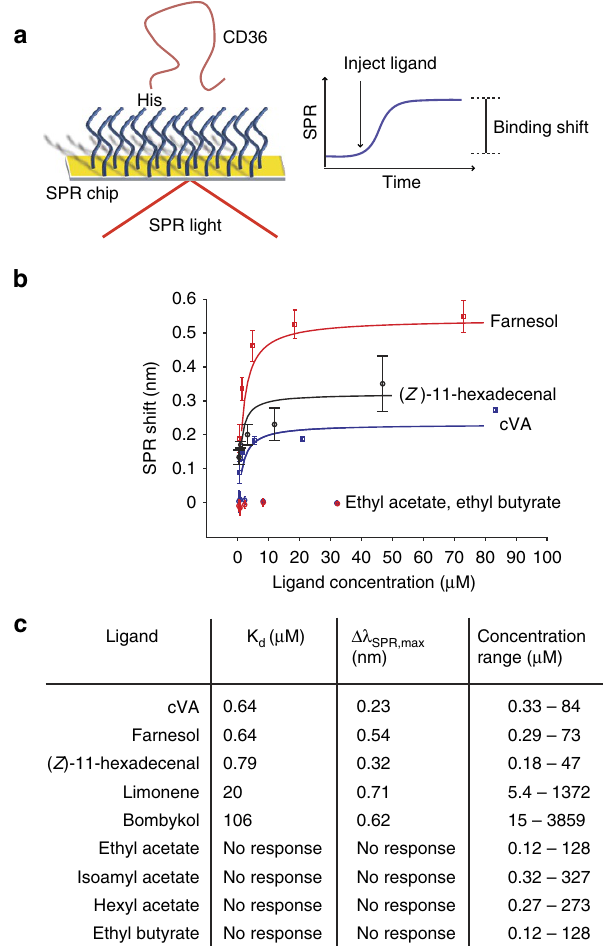
Figure 6 | The CD36 ectodomain binds insect pheromones. ( a ) Schematic representation of the SPR method for assessing small-molecule interactions with a CD36 sensor chip (adapted from ref. 70). ( b ) Concentration– response curves of D l SPR for the indicated ligands, which were used to calculate corresponding dissociation constants ( K d ). ( c ) K d and maximum SPR signal ( D l SPR,max ) for the indicated